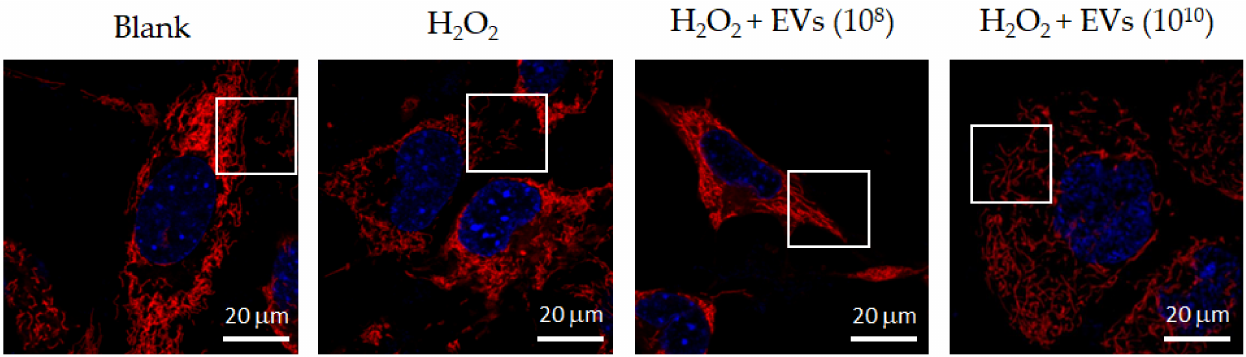
Figure 8. Inhibition of mitochondrial fission in H 2 O 2 -induced 3A-sub-E placental cells by L. crispatus - derived EVs (final concentration: 10 10 particles/mL) after treatment for 24 h, observed by MitoTracker Deep-Red staining and confocal microscopy. Mitochondrial morphology as shown in white